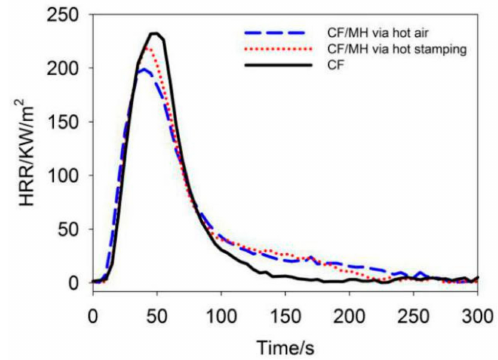
Figure 6. HRR curves of CF, CF / MH via hot air, and CF / MH via hot